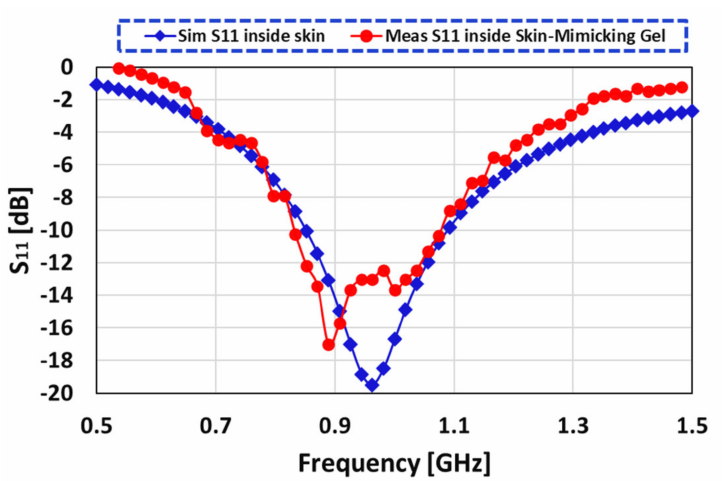
Figure 9. Contrast between the simulation and measurement results of S 11 inside